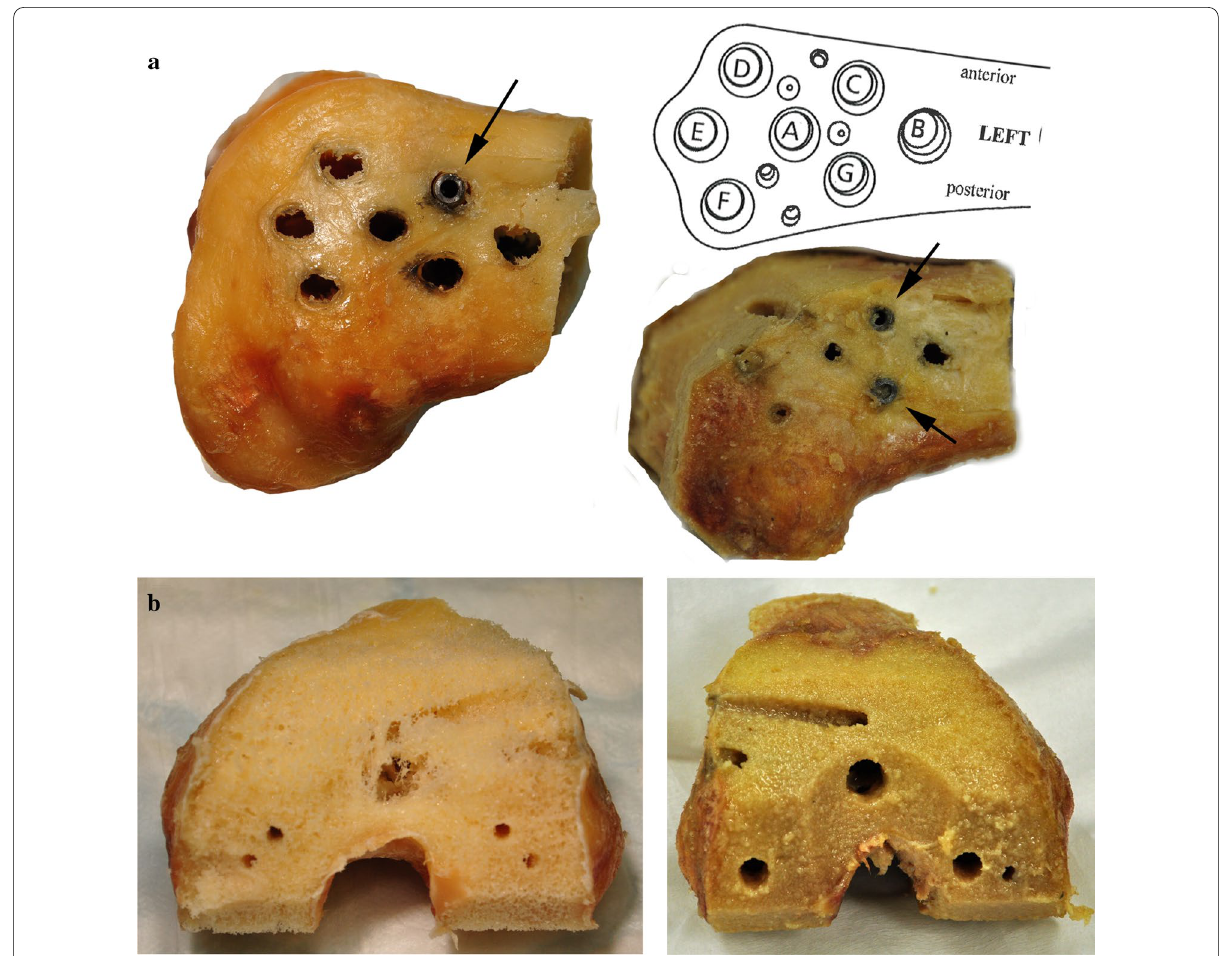
Fig. 2 Knee arthroplasty instrumentation. a Images of two distal femoral condyles after implant removal; broken screws are present in holes C and holes C and G, respectively (indicated by arrows ). Broken screws were principally detected in holes B, C, and G (see schematic). b Images visualizing situations after completing all resections. No interference with the remaining screws or cement was